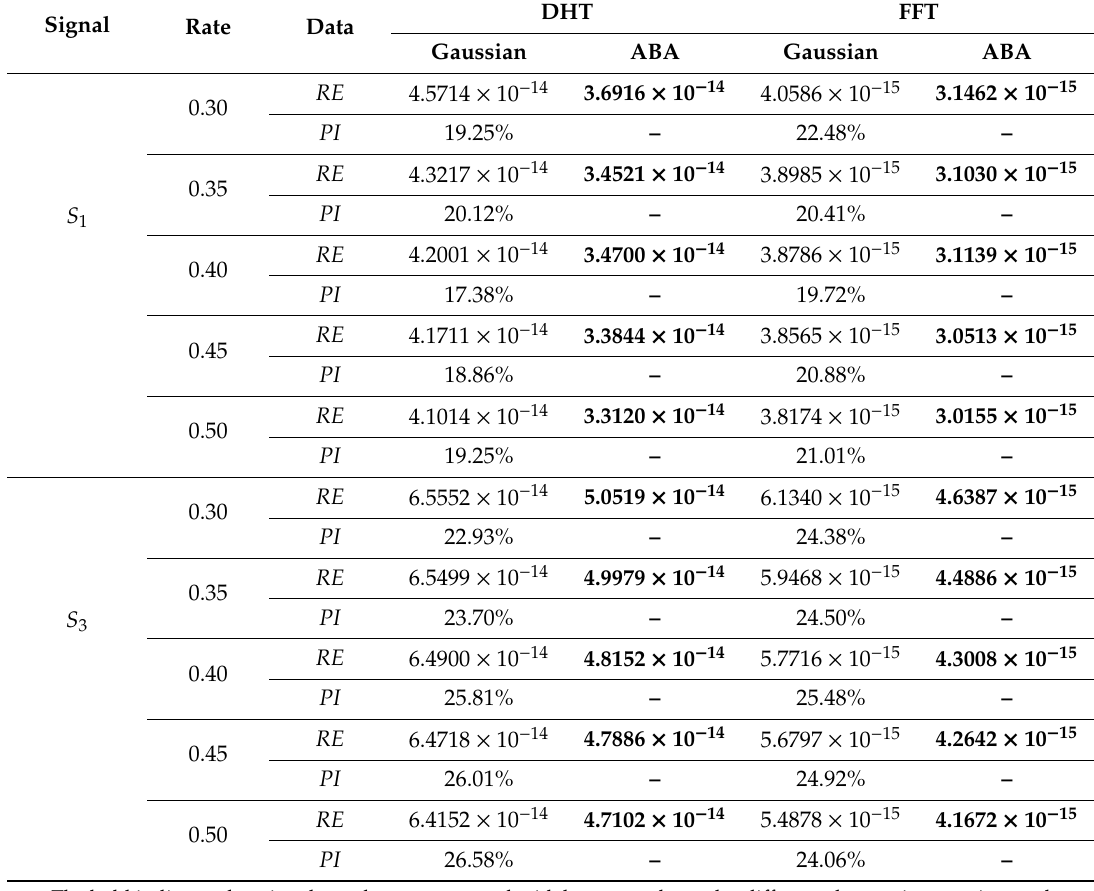
e ff ects of di ff erent transform bases based on adaptive bat algorithm are compared, and the robustness of the algorithm is fully proved. The results of the experiment are shown in Table 4. Table 4. Reconstruction e ff ect of di ff erent observation matrices and transform bases.